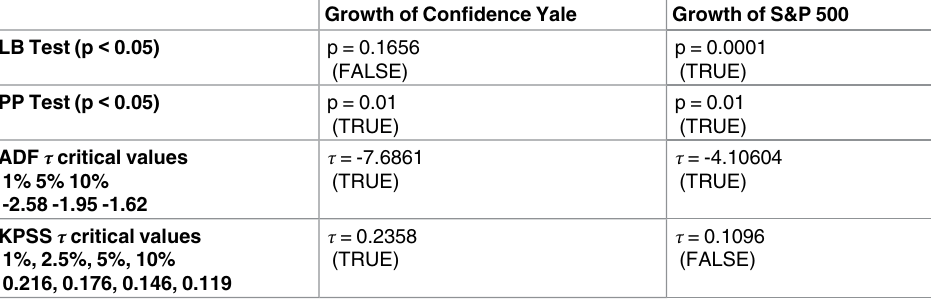
Table 8. Unit root tests for the growth indexes.